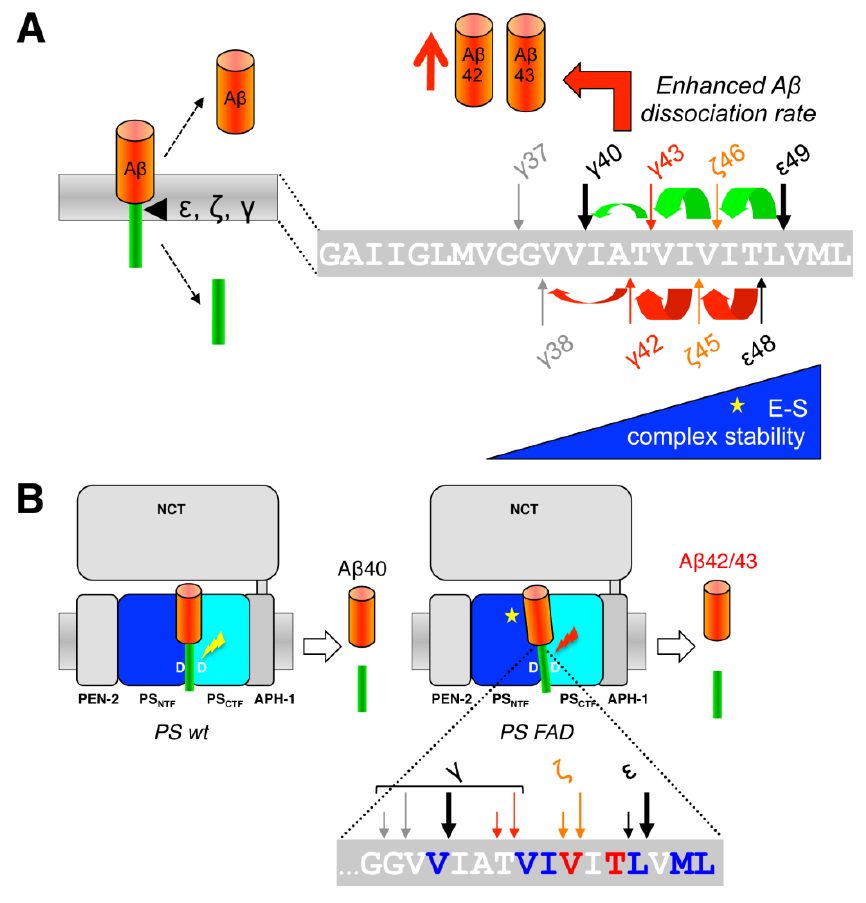
FIGURE 6: Mechanism of prese- nilin FAD mutations. (A) Model depicting impaired processivity